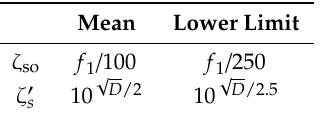
Table 5. Values of ζ so and ζ (cid:48) s in Engineering Science Data Unit (ESDU)